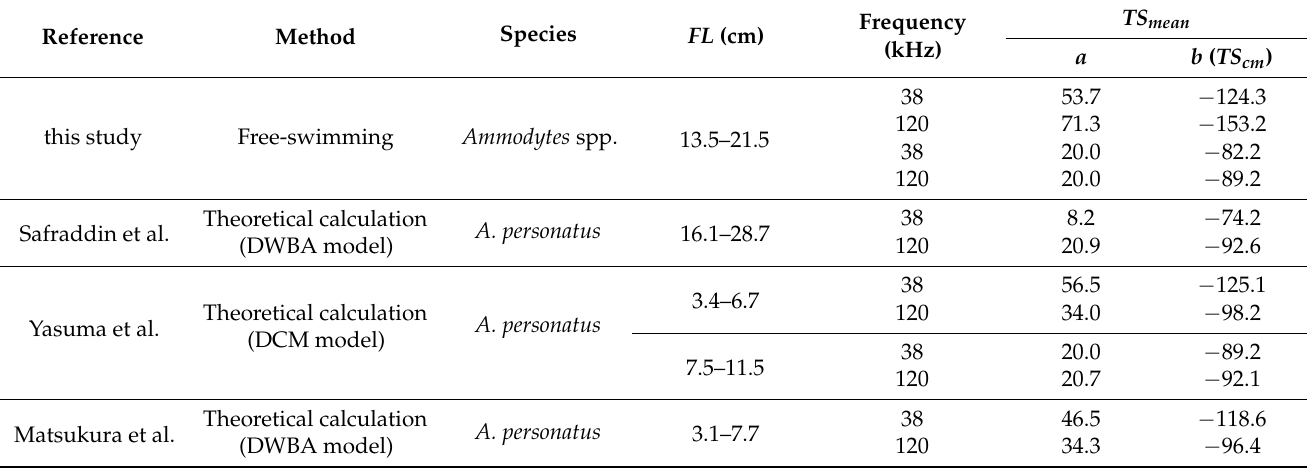
Table 4. Coefficients for TS mean —body length equations for sandeels in our study and previous research. (Previously, the A. personatus and A. hexapterus have been recognized in the waters sur- rounding Japan. However, a taxonomic reexamination based on genetic and morphological analyses has led to the description of a new species, A. heian , and the scientific name A. japonicus should be applied to the A. personatus